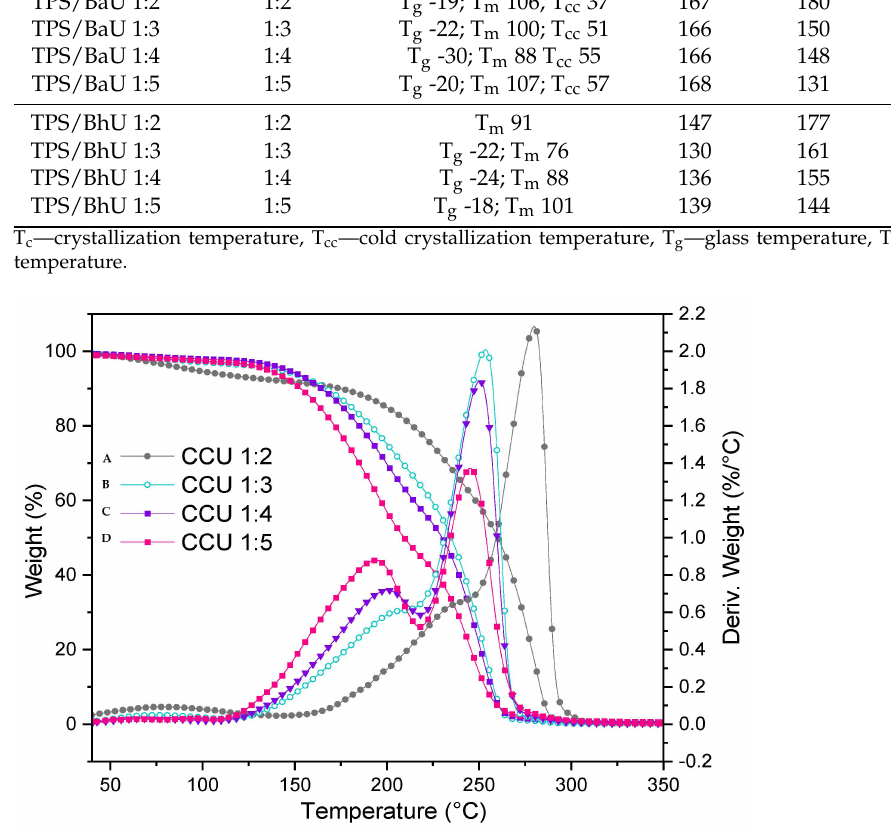
Figure 1. DMTA curves (A) Tan δ for TPS/CCU; (B) Tan δ for TPS/BaU and (C) Storage modulus − E’ for TPS/CCU; (D) Storage modulus − E’ for TPS/CCU; The analysis was performed on thermocom- pressed TPS